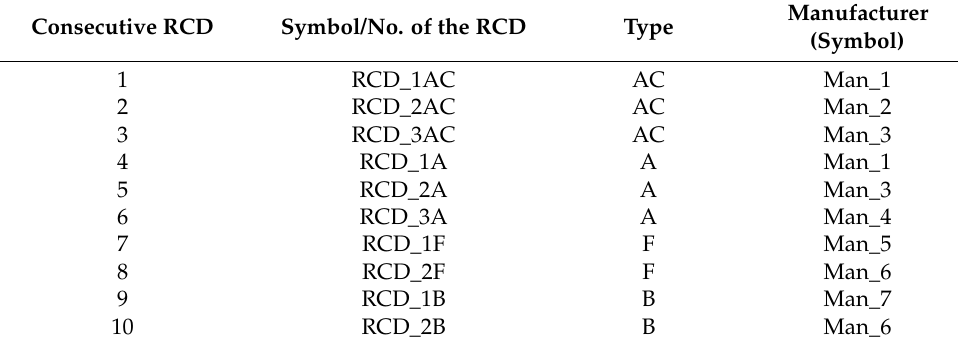
Table 2. List of the selected RCDs ( I Δn = 30 mA).